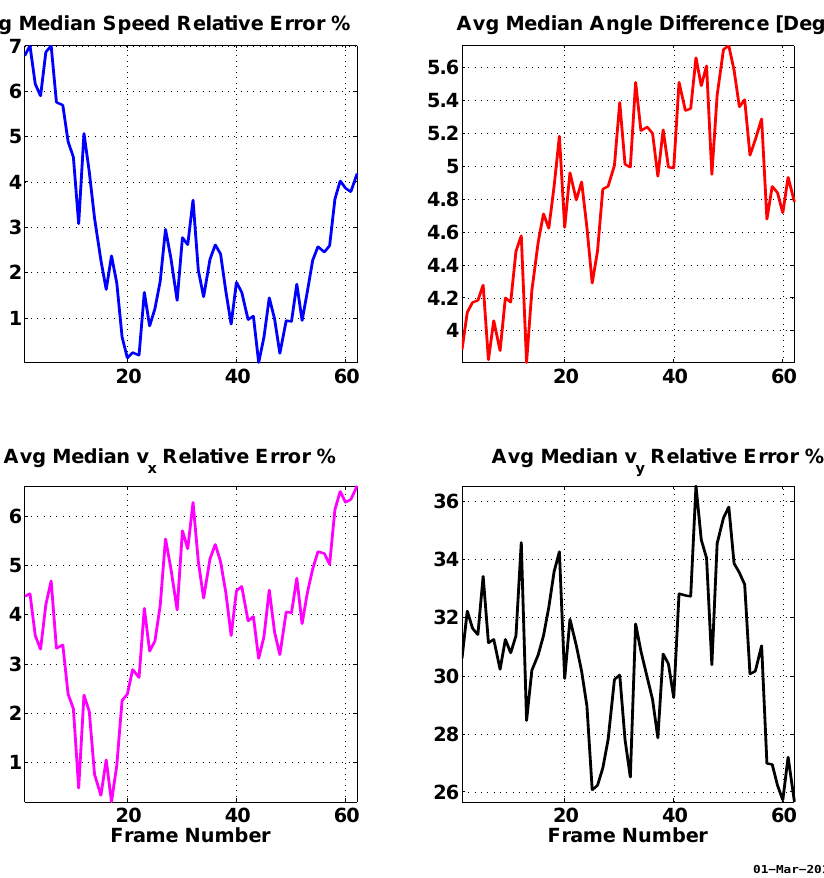
Figure 6. Associated summary median percent relative error statistics for 64 time-lapse image